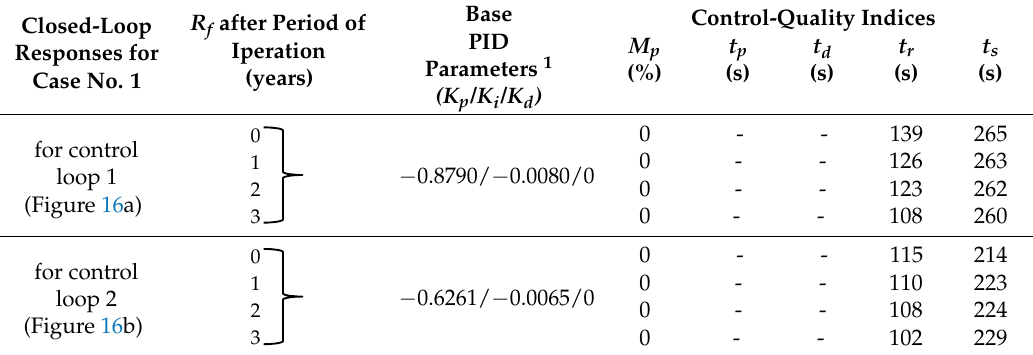
Figure A4. Closed-loop step responses (case in work [6]) under fouling conditions of the HE E35AB models: without adjustment ( a ) after adjustment ( b ) and after adjustment of optimal ( c ) PID tuning parameters.